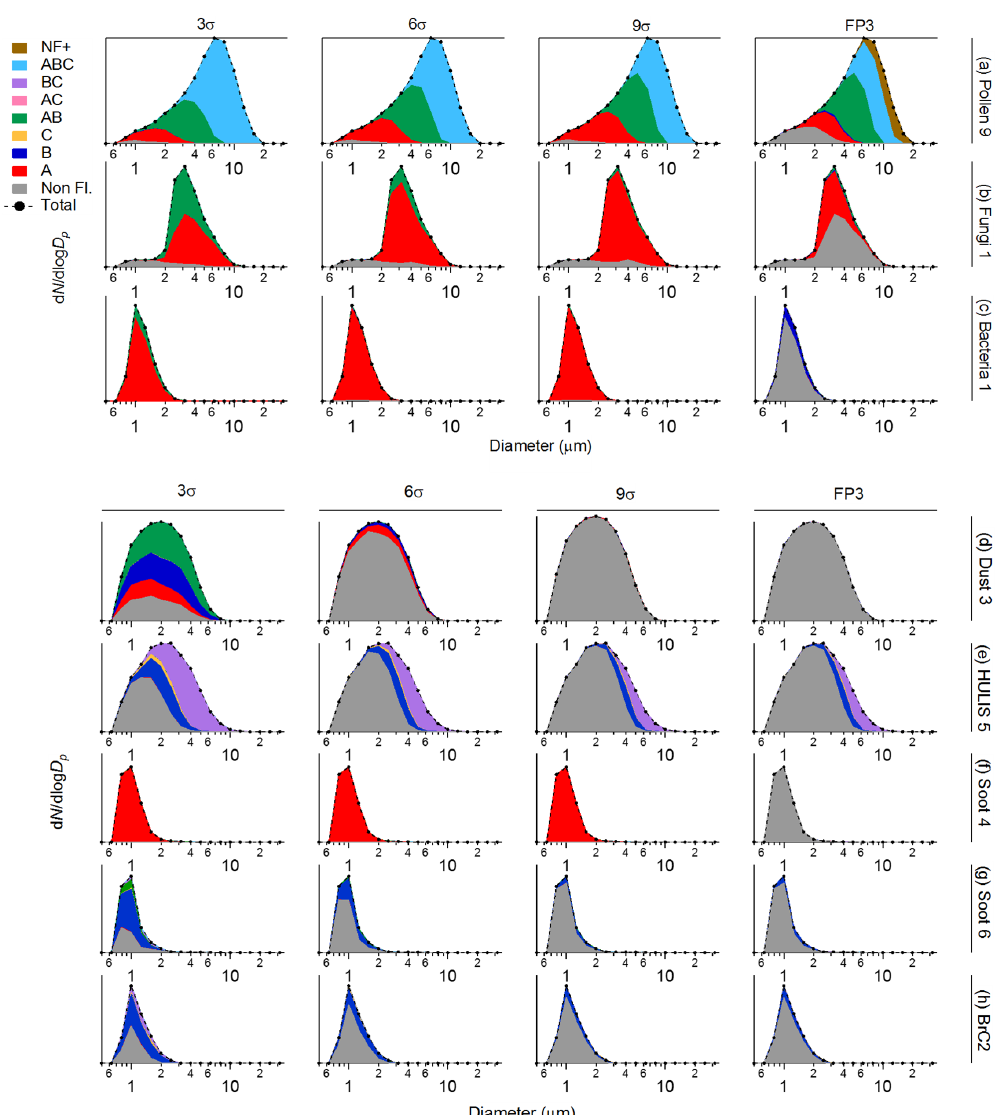
Figure 7. Stacked particle type size distributions for representative particle classes shown using four separate thresholding strategies. NF + particle type (right-most column) represents particles that exceed the FL2 and/or FL3 upper bound of the Wright et al. (2014) FP3 definition and that are therefore considered as one set of “non-fluorescent” particles by that definition. Legend above top rows indicate threshold definition